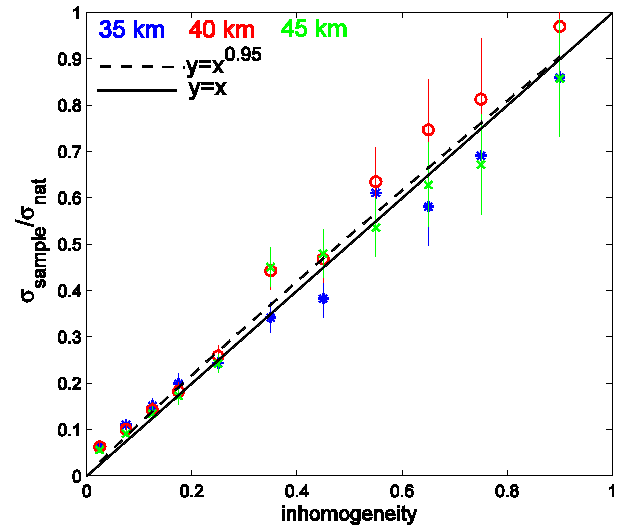
σ on the inhomogenei- σ nat H σ σ= ⋅ . sample tot nat